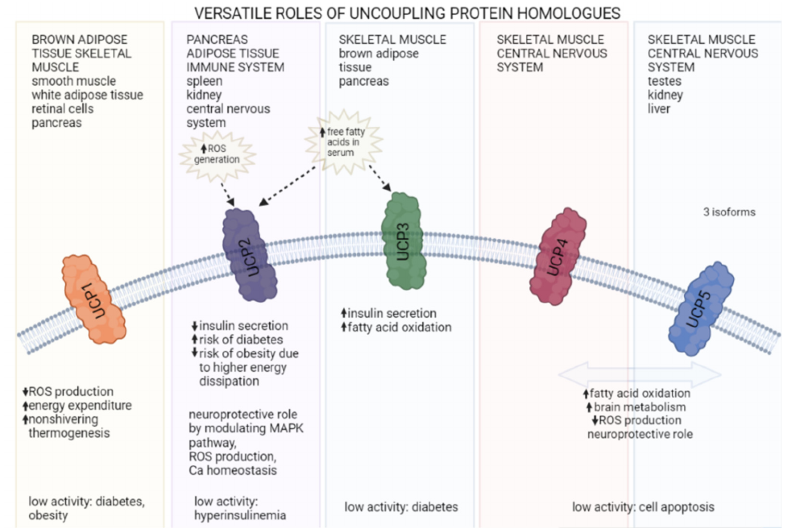
Figure 2. UCP homologs are present in different tissues and have distinct roles. Arrows up represent an increased activity, arrows down represent a decreased activity (created with BioRender.com, (accessed on 19 January 2022)).